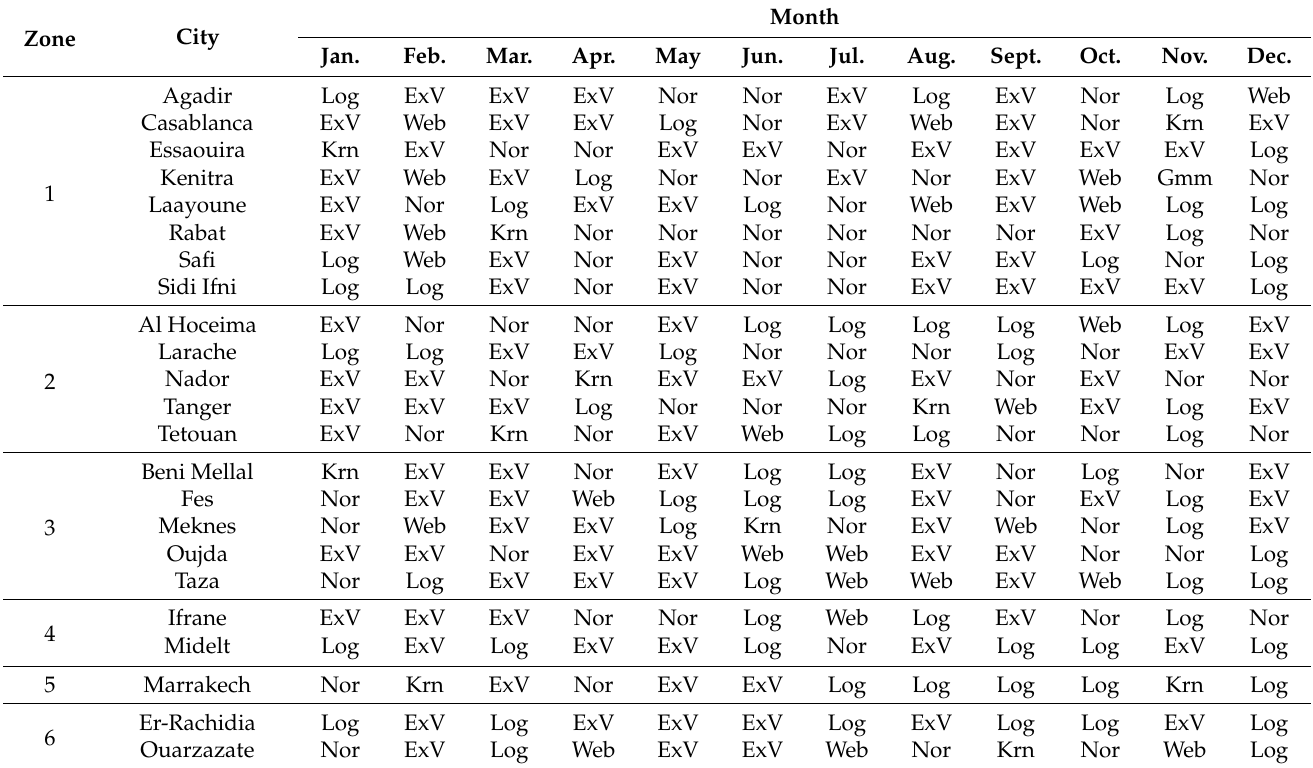
Table 6. PDFs for the DNI case for each city and month (normal = Nor, logarithmic = Log, extreme